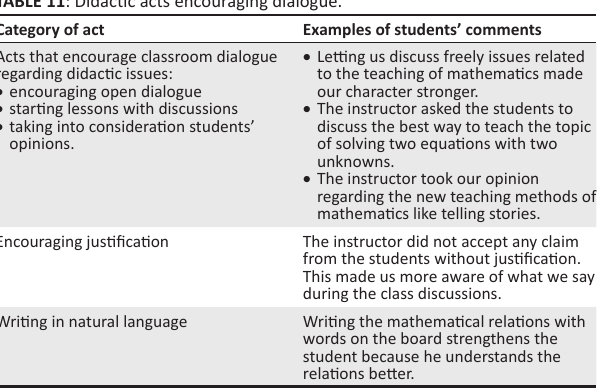
TABLE 11 : Didactic acts encouraging dialogue. Category of act Examples of students’ comments